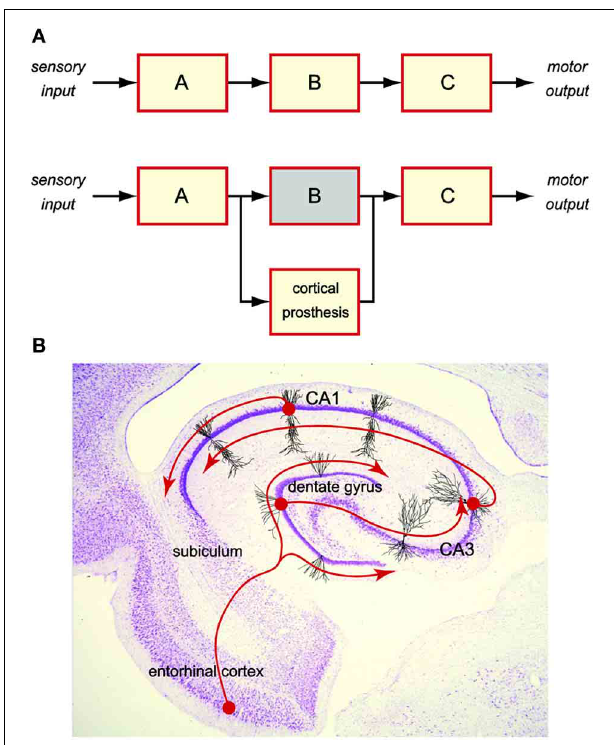
FIGURE 1 | Cortical prosthesis restores cognitive functions by bypassing the damaged brain region to maintain the brain signal flow. (A) Schematic diagram of a cortical prosthesis. (B) Intrinsic tri-synaptic pathway of the hippocampus.